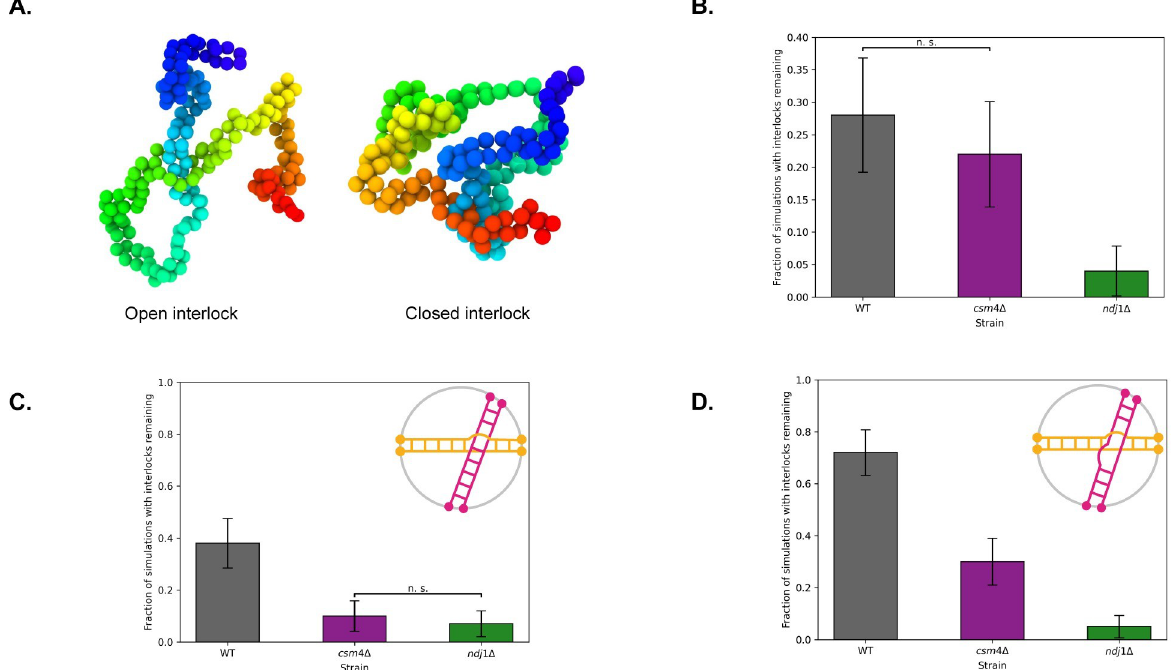
Fig 6. Role of RTMs on interlocks. (A) Model captures both types of interlocks that are known to occur experimentally. (B) Loss of RTMs leads to a greater percentage of cells with interlocks. (C) Resolution of Open Interlocks. Graph shows percent of simulations with interlocks remaining after ~ 2 hours in the case that chromosomes start in an open interlock configuration (lower left). (d) Percent of simulations with interlocks remaining after ~ 2 hours in the case that chromosomes start in a closed interlock configuration (lower right). Error bars indicate 95% confidence intervals.